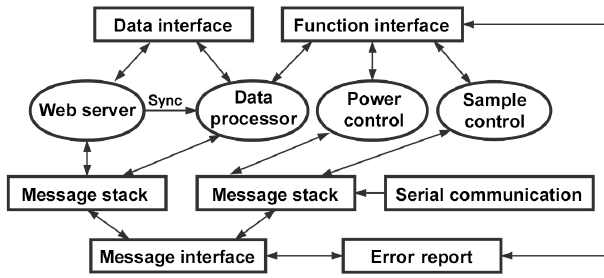
Figure 5. The packaging design of a process